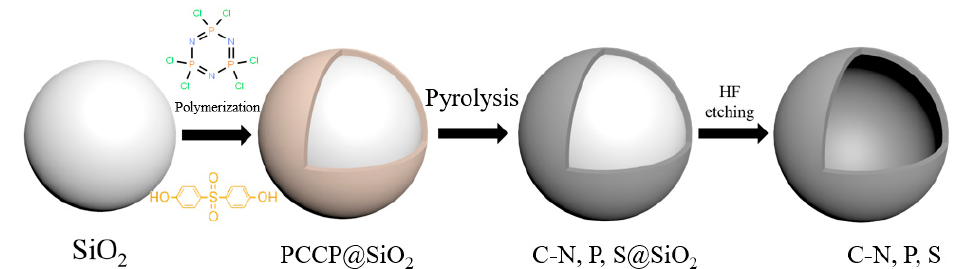
Figure 6. Schematic illustration for fabrication of hollow C–N,P,S sphere.